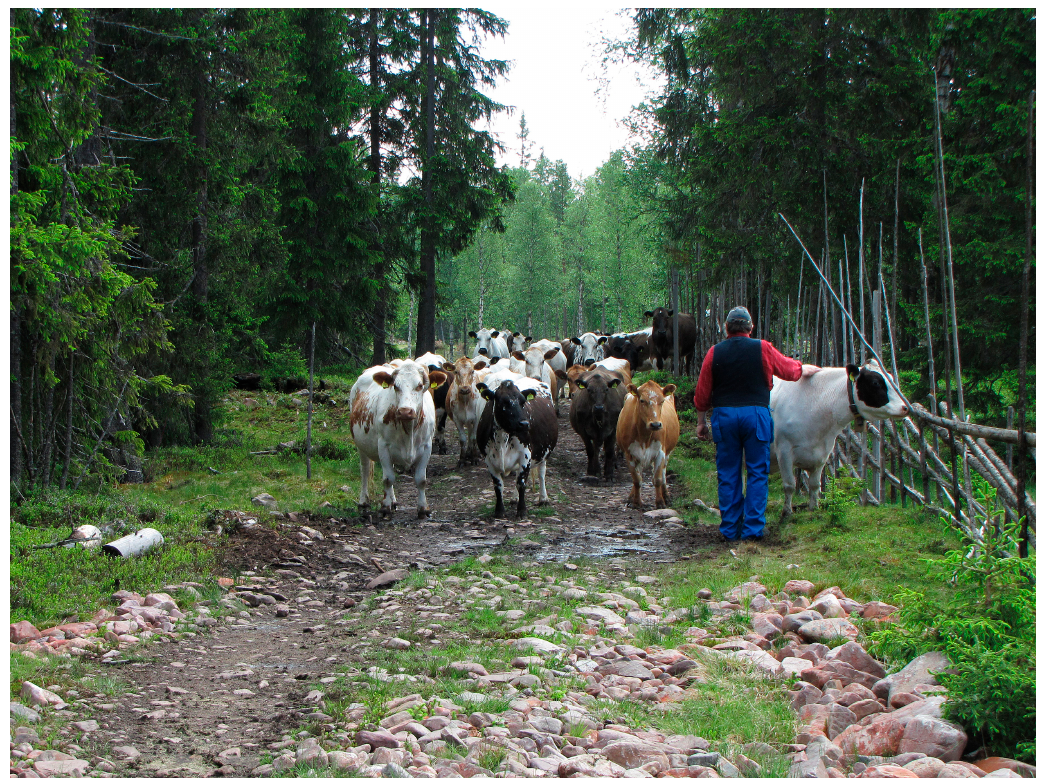
Figure 3. Vålbrändan summer farm in the county of Dalarna, in the year of 2011. Now the forest is denser around the summer farms due to reforestation in recent years. Photographer: Tommy Lennartsson.